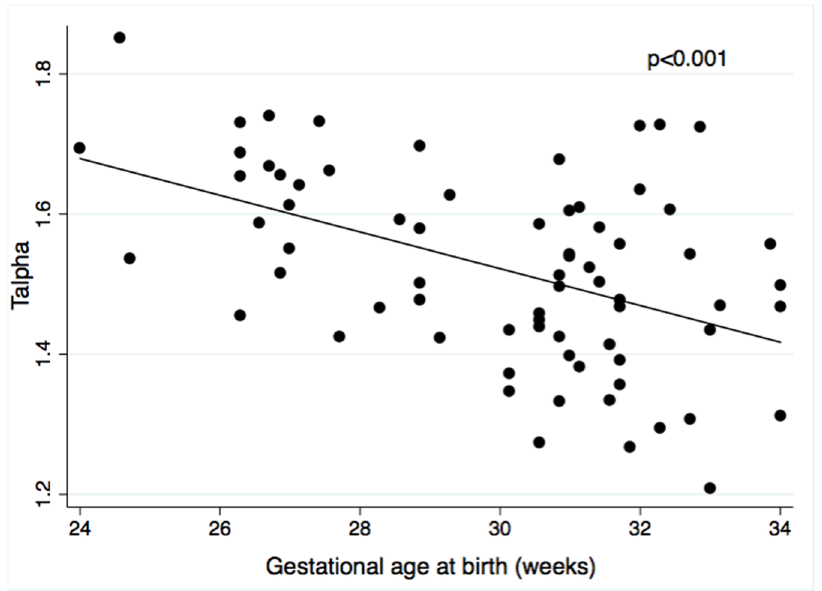
Fig 2. Scaling exponent alpha (T alpha ) over gestational age (GA). Average T alpha over the first five days of life derived from detrendedfluctuationanalysisof temperature time series plotted againstGA at birth. Multilevellinear regressionanalysisdemonstrated a significantnegative association between T alpha and GA at birth (p < 0.001,R 2 = 0.29).